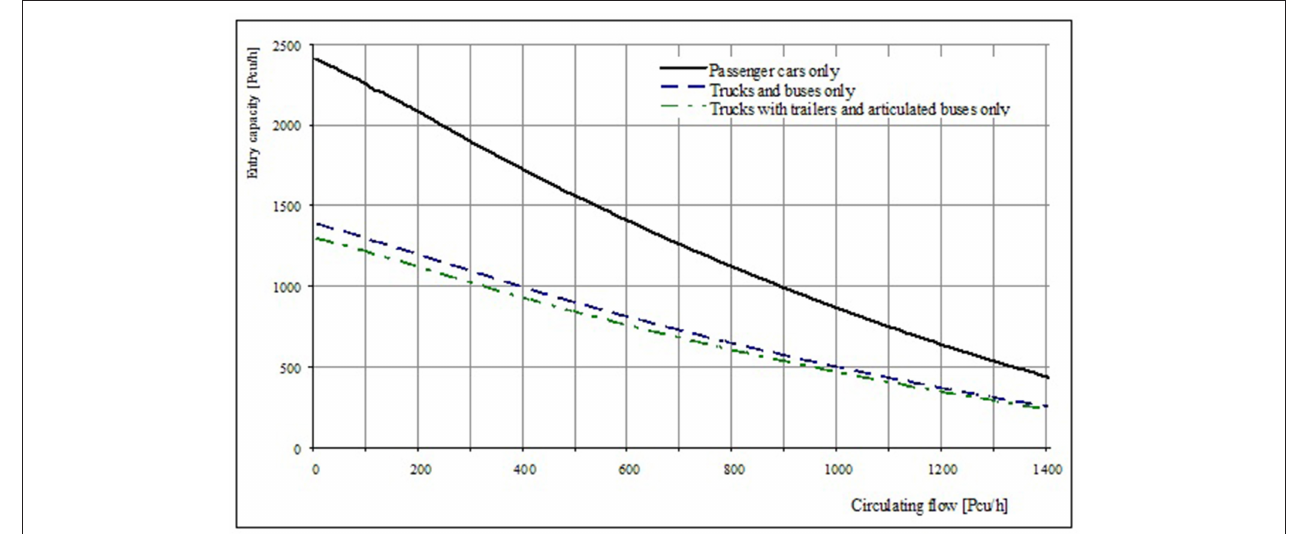
FIGURE 9 | Turbo roundabout entry capacity for passenger cars only and heavy vehicles only.